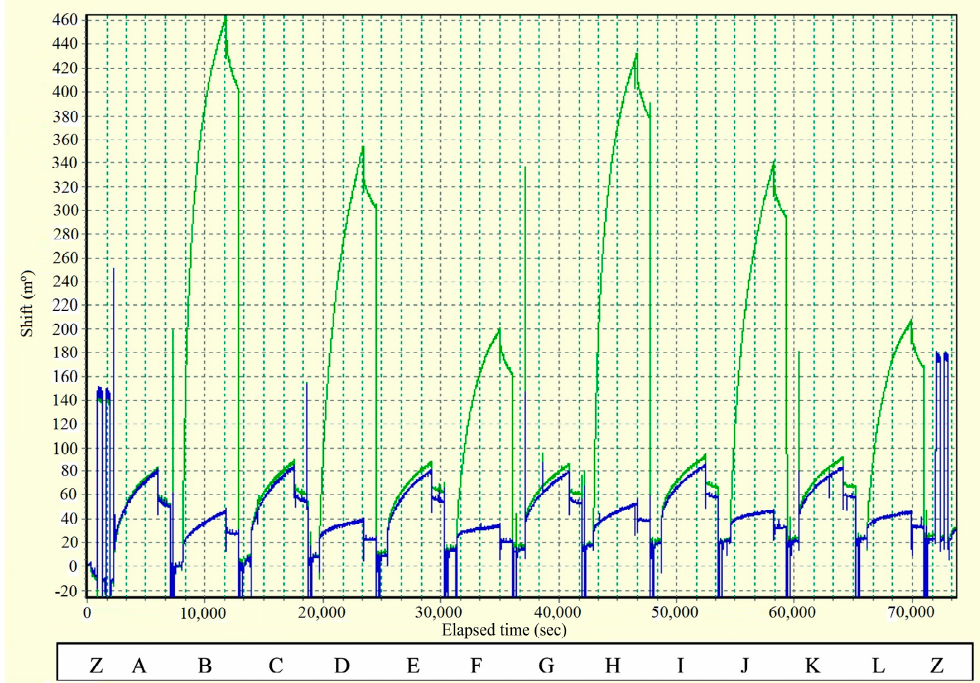
Figure 18. Sensorgram of citrulline peptide containing spot (green) and its arginine control spot (blue).